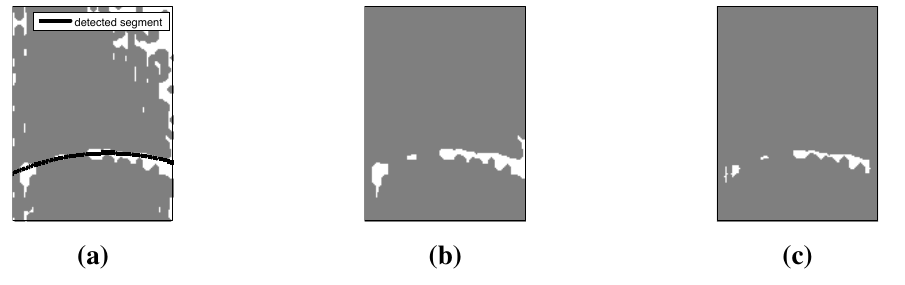
Figure 5. Level detection. ( a ) Gradient mask with detected segments; ( b ) Extracted segments; ( c ) Sorted and smoothed